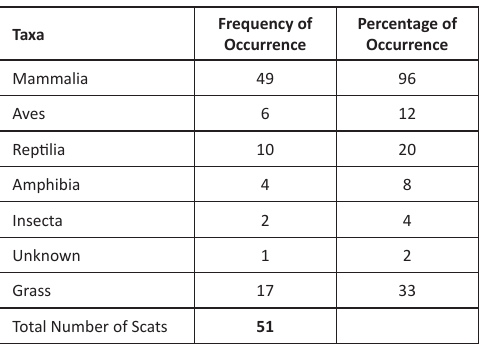
Table 3. Frequency of occurrence of the different vertebrate groups in leopard cat scats. Frequency of Taxa